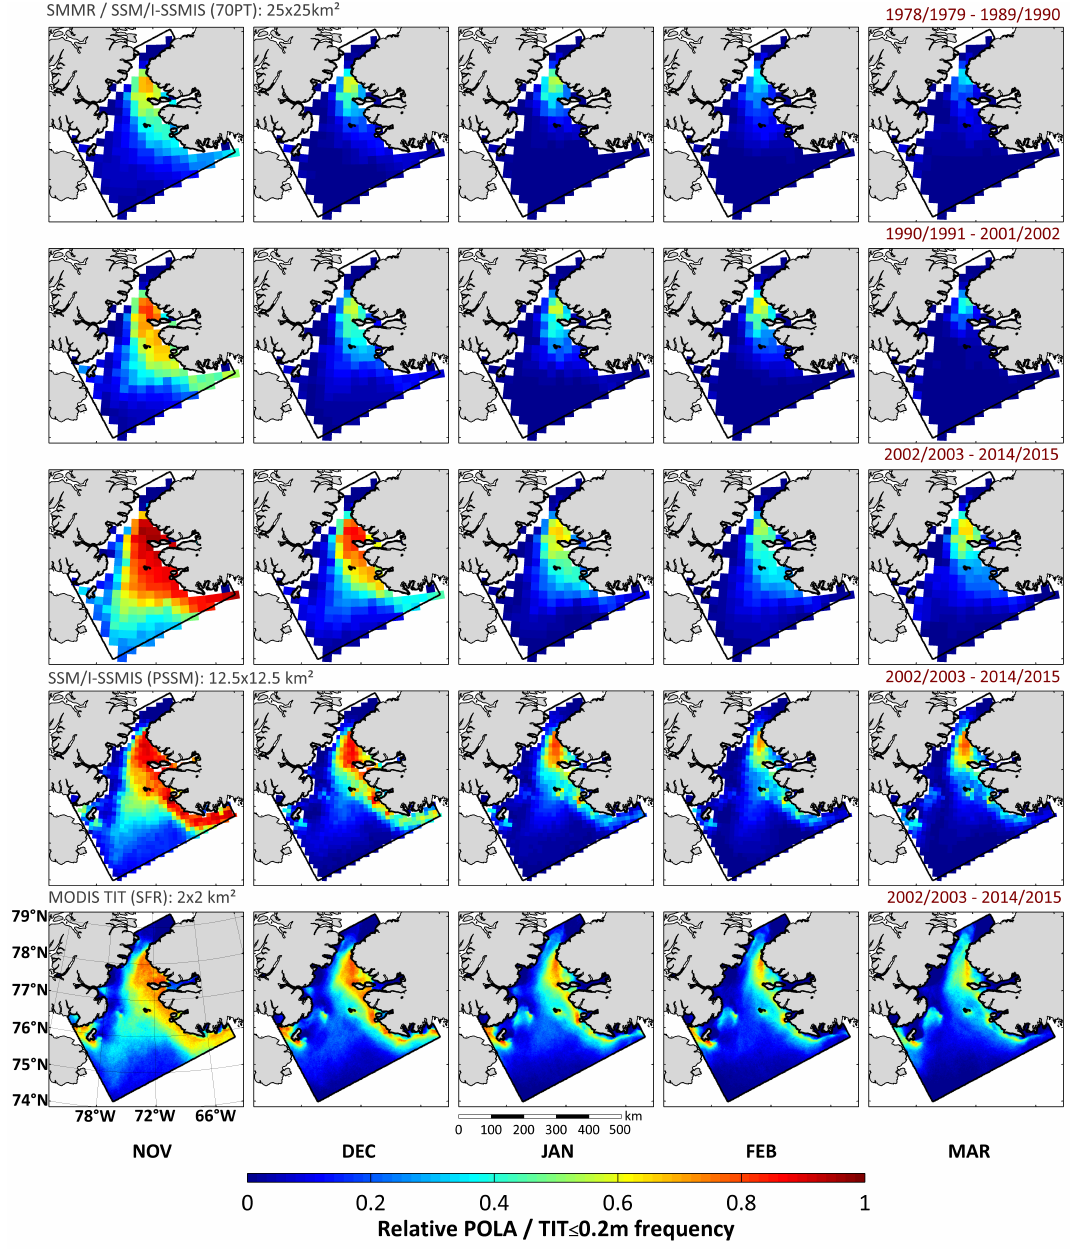
Figure 5. Average monthly relative frequency distribution of polynya-pixels as classified by the 70PT-method (SMMR/SSM/I-SSMIS; top three rows), the PSSM method (SSM/I-SSMIS); fourth row) and based on MODIS thin-ice thicknesses ď 0.2 m (daily TIT composites with applied spatial feature reconstruction (SFR); bottom row). Note the reference period over which the monthly relative frequency distributions are calculated, as indicated in the the upper right corner of each